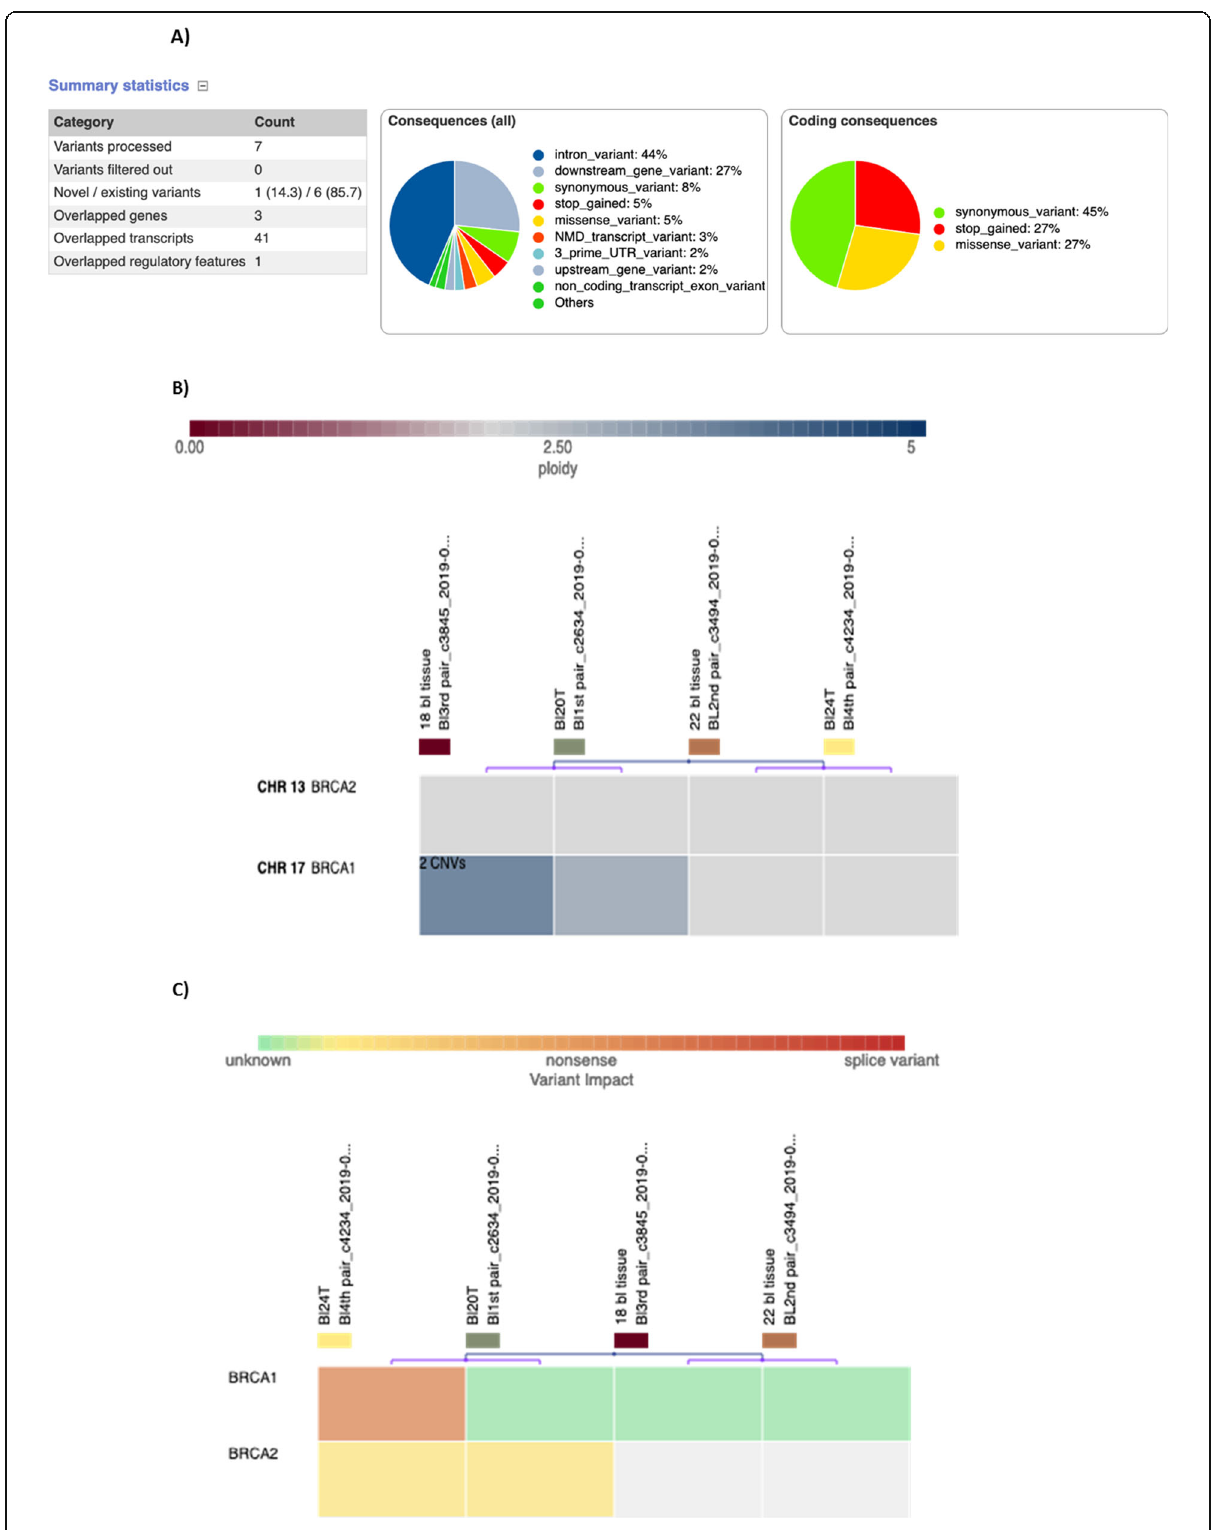
Fig. 2 Analysis of NGS data report for the investigated samples. a Variant effect predictor diagram showing the detect variant effects in different BRCA transcripts. b Variant impact diagram showing the CNV heatmap. c Variant impact diagram showing the detected variants